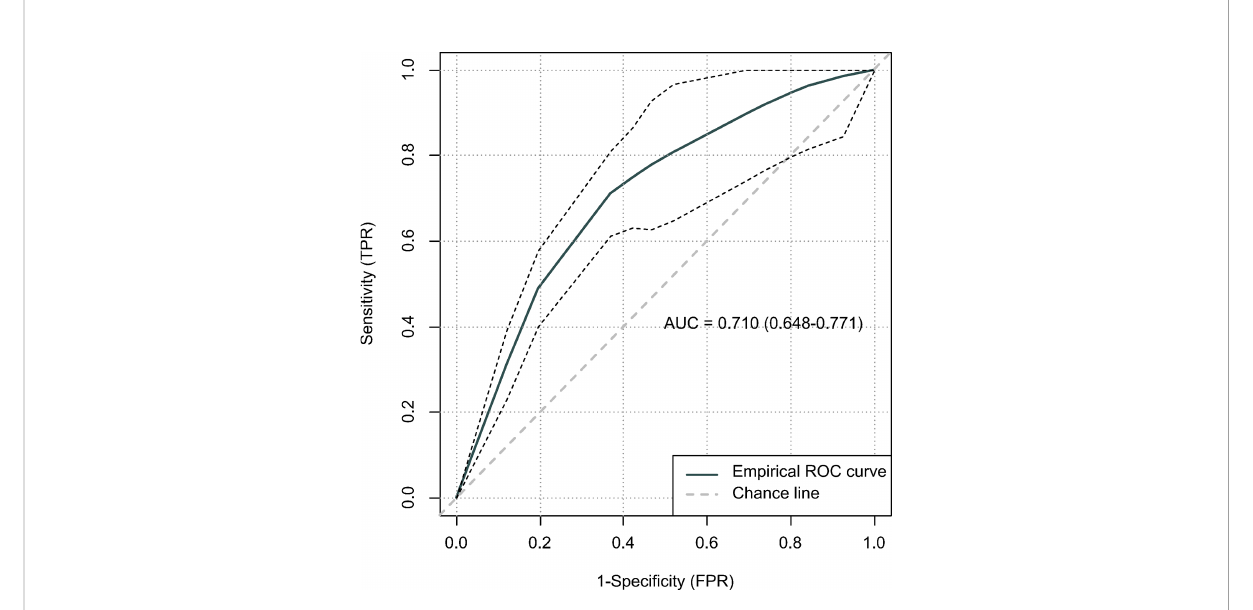
FIGURE 5 The predictive performance of the classi fi cation and regression tree (CART) using receiver operating characteristic (ROC)